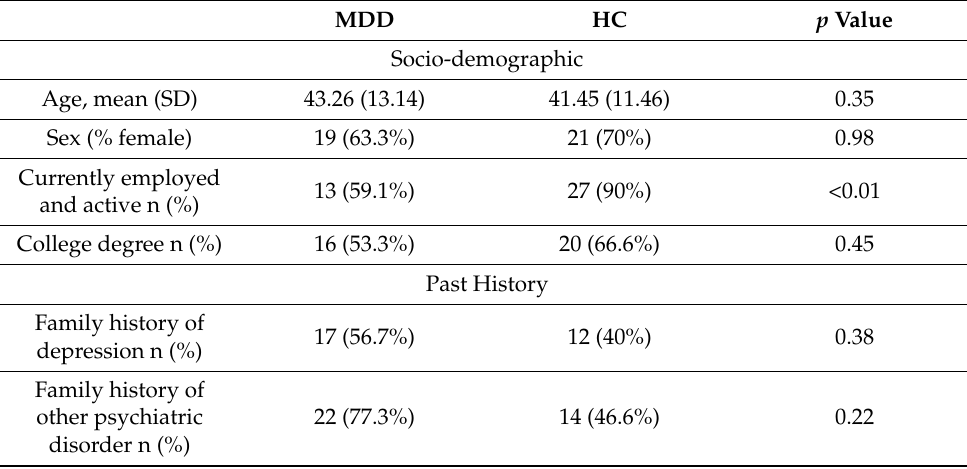
Table 1. Baseline characteristics of